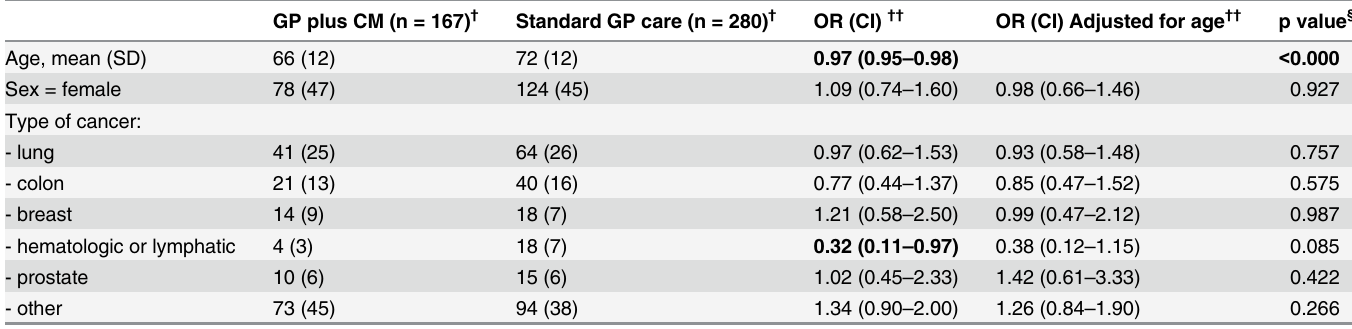
Table 1. General characteristics of cancer patients with additional support from a case manager and patients receiving standard GP